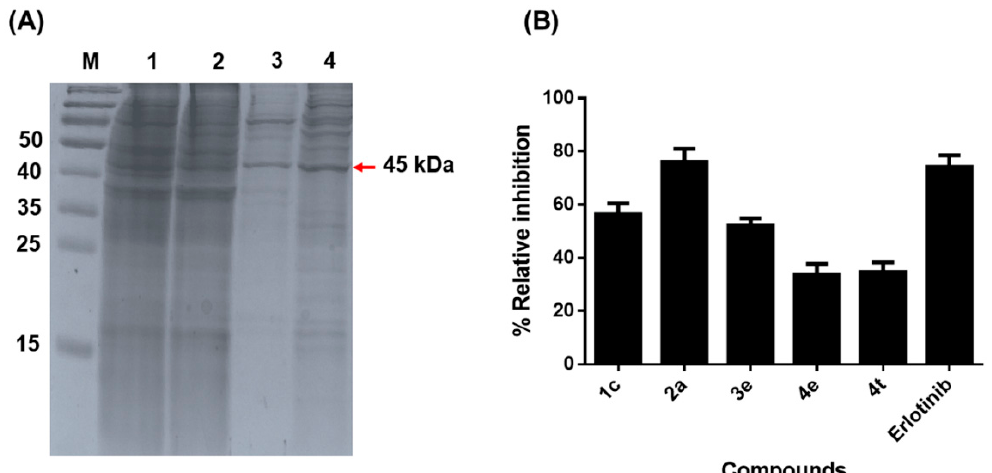
Figure 3. ( A ) Representative sodium dodecyl sulfate-polyacrylamide gel electrophoresis (SDS-PAGE) gel analysis of the enrichment of the r EGFR-TK intracellular domain (ICD), loading 5 µg protein per track. Lane M: molecular weight marker of standard protein; Lane 1: supernatant, Lane 2: Flow through, Lane 3: 10% of buffer B, Lane 4: 45 kDa of EGFR-TK domain ( B ) The relative r EGFR-TKI activity (%) of the five potent chalcone derivatives and erlotinib at 1 µM, as assayed using the ADP-glo kinase assay. Data are shown as the mean ± one standard deviation, derived from three independent repeats. Means with a different letter are significantly different (p < 0.05).